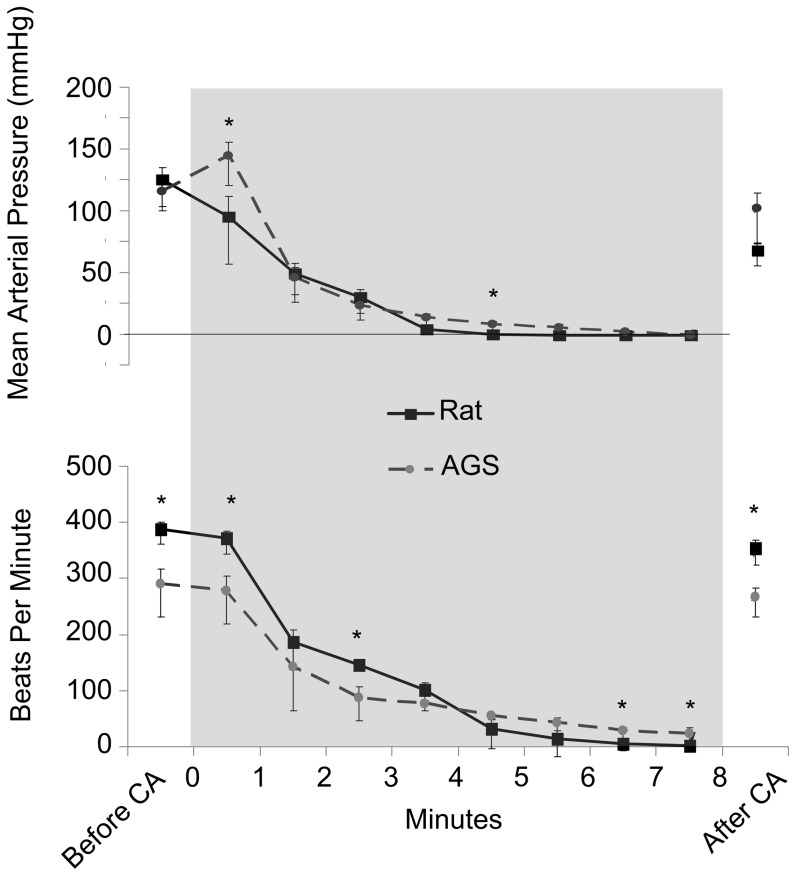
The mean arterial blood pressure and average heart rate decrease during cardiac arrest.Both mean arterial pressure (MAP; top) and heart rate (HR; bottom) decrease similarly for both AGS and rat and return to near normal after CA. Darkened area represents period of asphyxia. MAP and HR were recorded immediately before asphyxiation (Before CA) and one hour after CA (After CA). Data shown as mean ± SEM, * Tukey, p<0.05 between rat and AGS. For both groups n = 5.